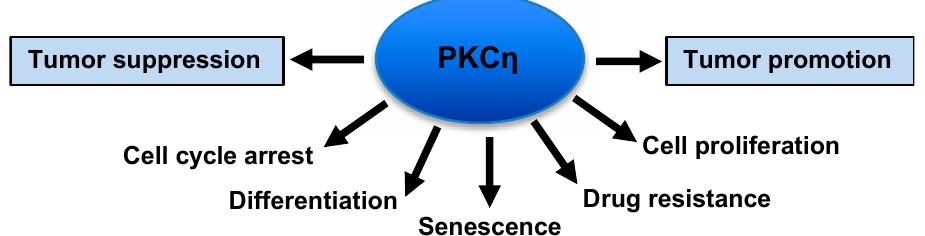
Figure 1. Various functions of protein kinase C-eta (PKC η ).